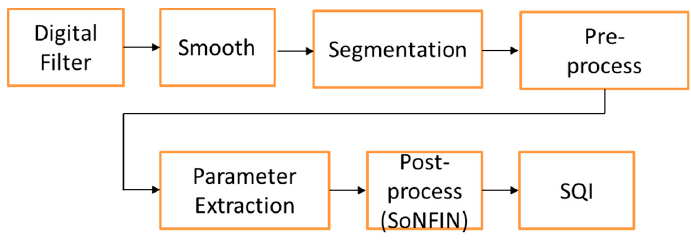
Figure 2. Flowchart of signal quality indexes (SQI) algorithm for each PPG pulse.